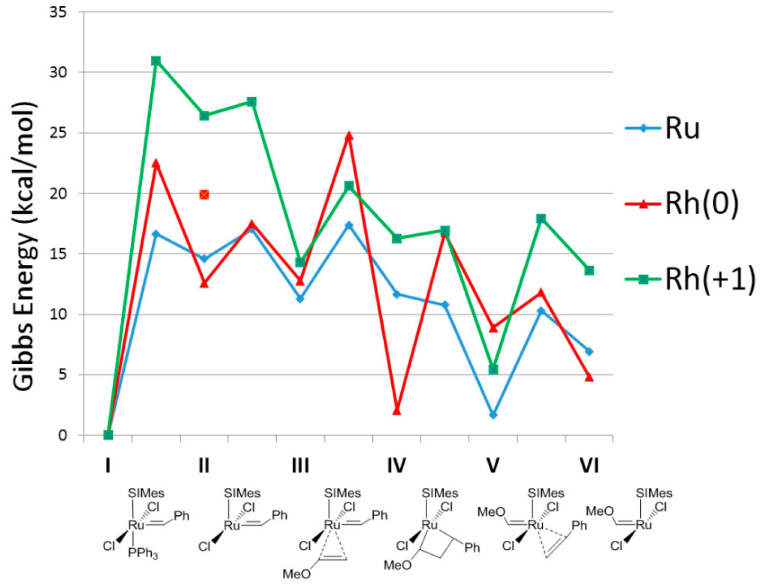
Figure 1. Computed stationary points for the olefin metathesis reaction pathway for M(SiMes)Cl 2 (=CHPh)PPh 3 with methoxyethene (M = Ru in blue, Rh(0) in red, Rh(+1) in green; energies in kcal/mol, selected distances in Å, the imaginary frequencies characterizing the transition